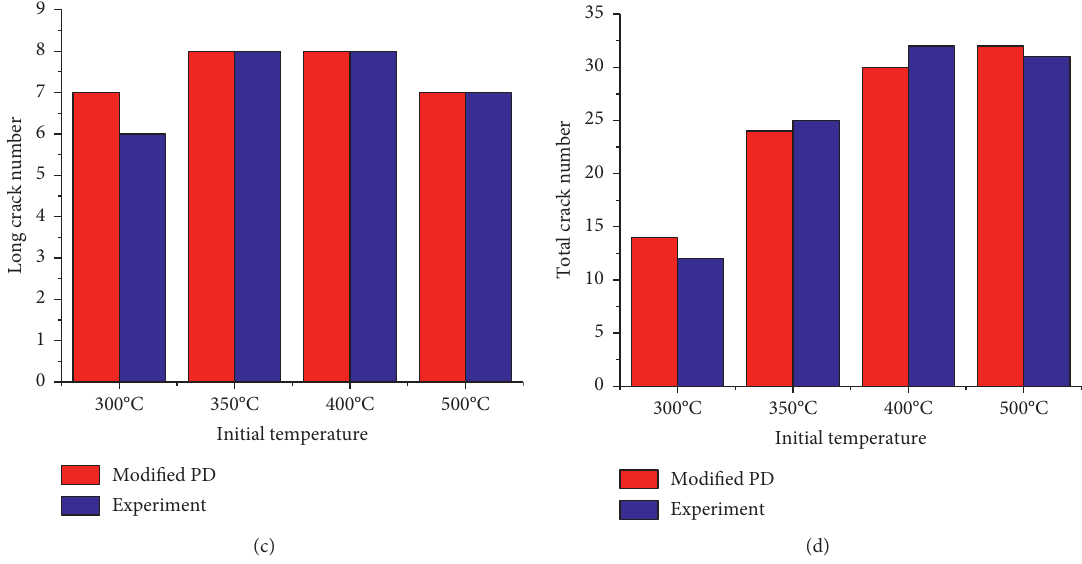
Figure 8: Thermal crack numbers at different initial temperatures: (a) short crack numbers; (b) medium-sized crack numbers; (c) long crack numbers; (d) total crack